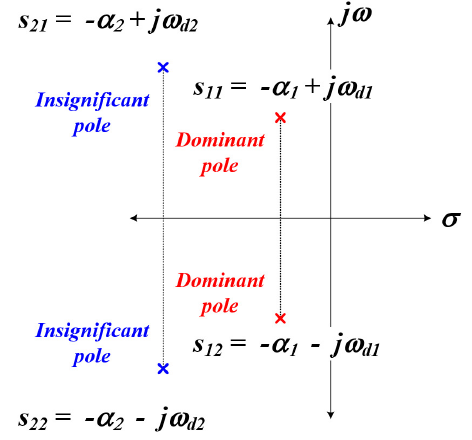
Figure 10. Fourth system